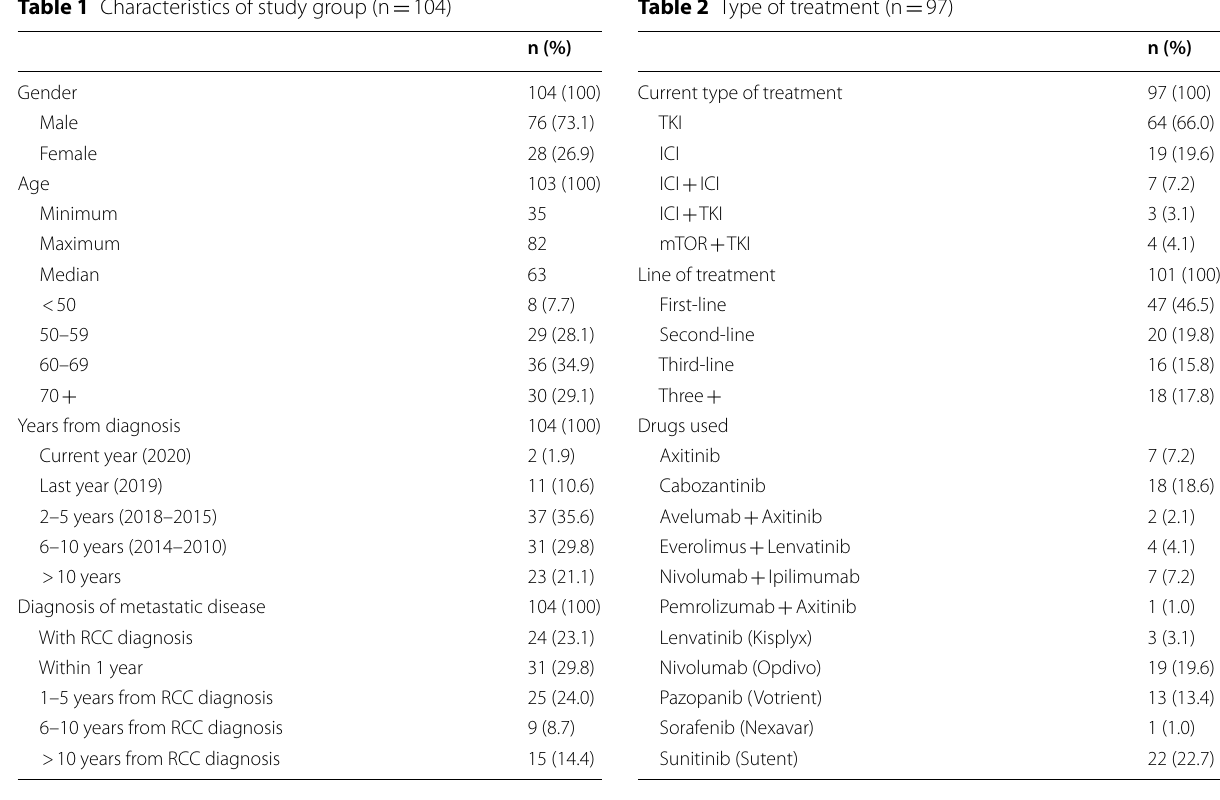
Table 1 Characteristics of study group (n